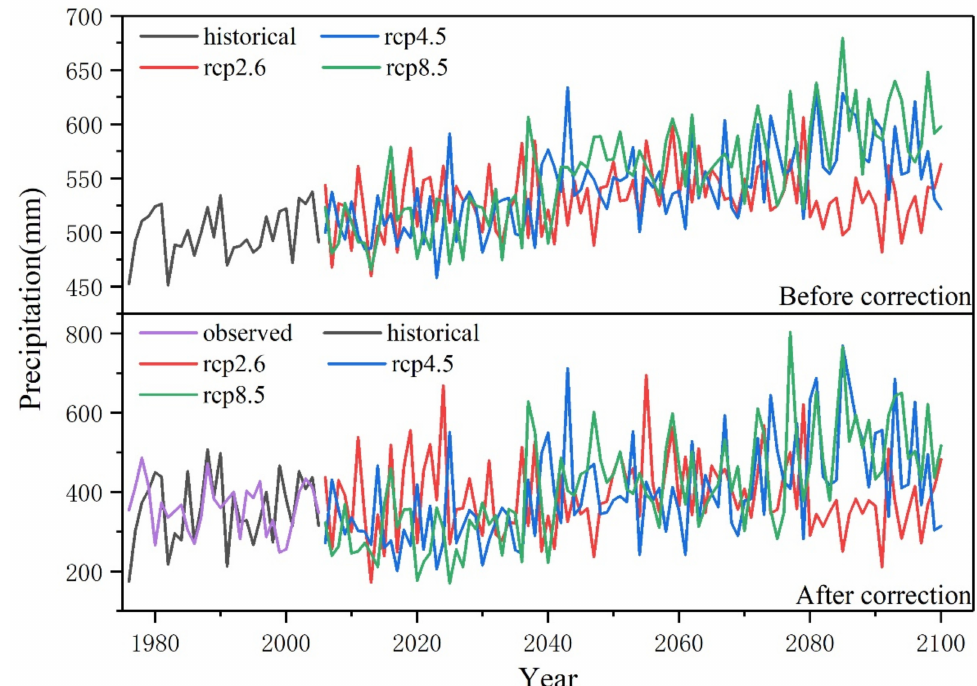
Figure 2. Time series of annual averaged precipitation in Huangfuchuan Basin from 1976 to 2100 for the multi-model ensemble. Above the dotted line is the time series before the Equidistant Cumulative Distribution Functions Matching Method (EDCDF) method correction, and below is the modified time series.